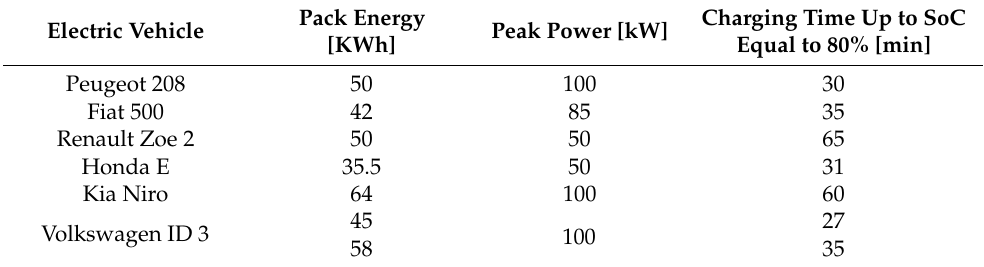
Table 1. Summary of fast charging parameters for several vehicles on the market.